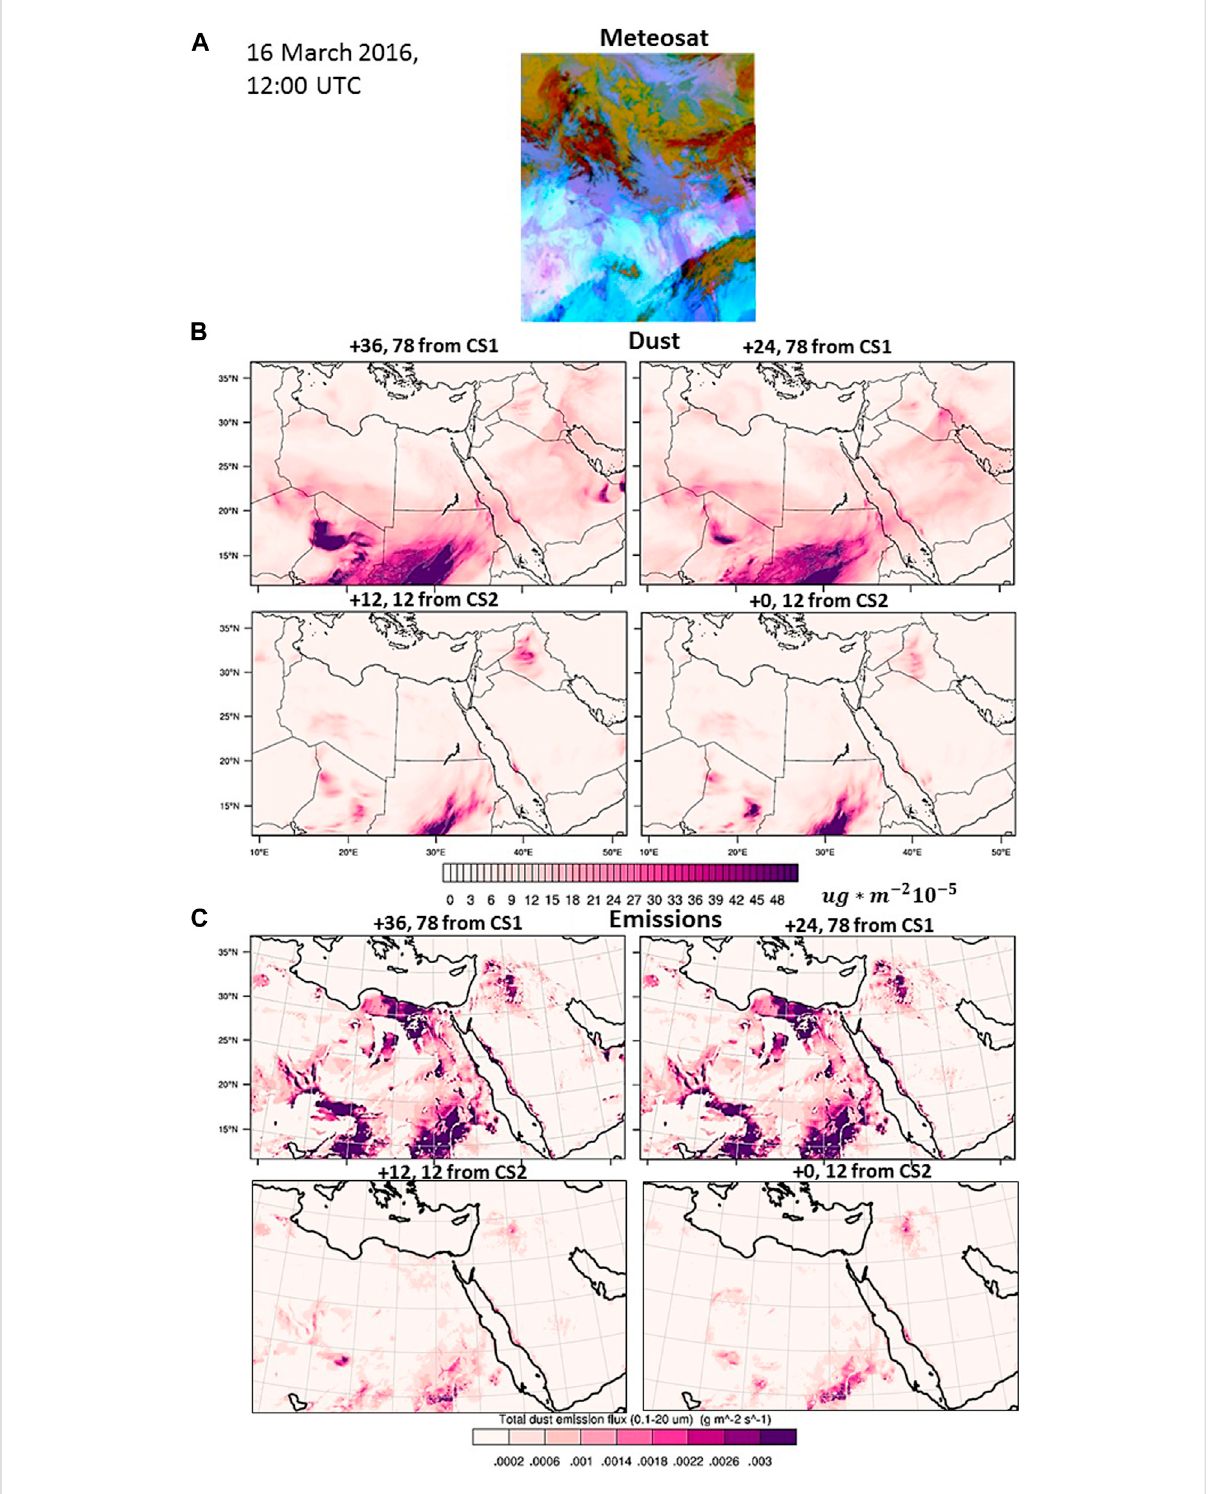
FIGURE 4 Same as Figure 3 but valid at 12 UTC 16 March